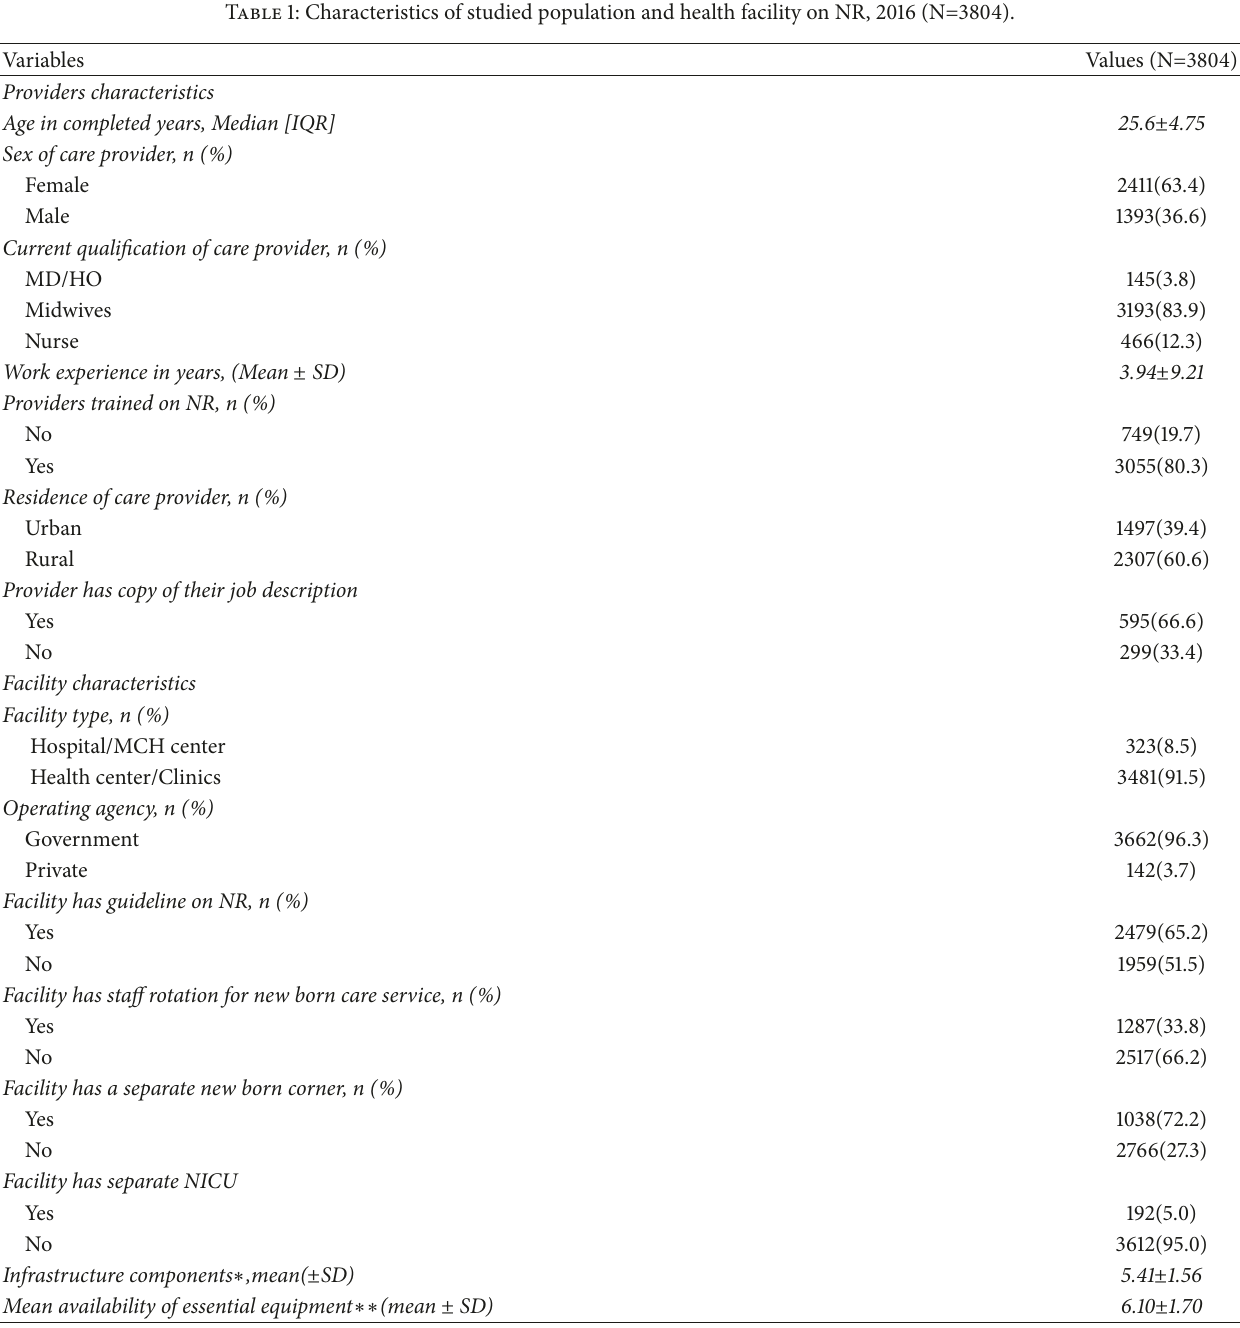
Table 1: Characteristics of studied population and health facility on NR, 2016